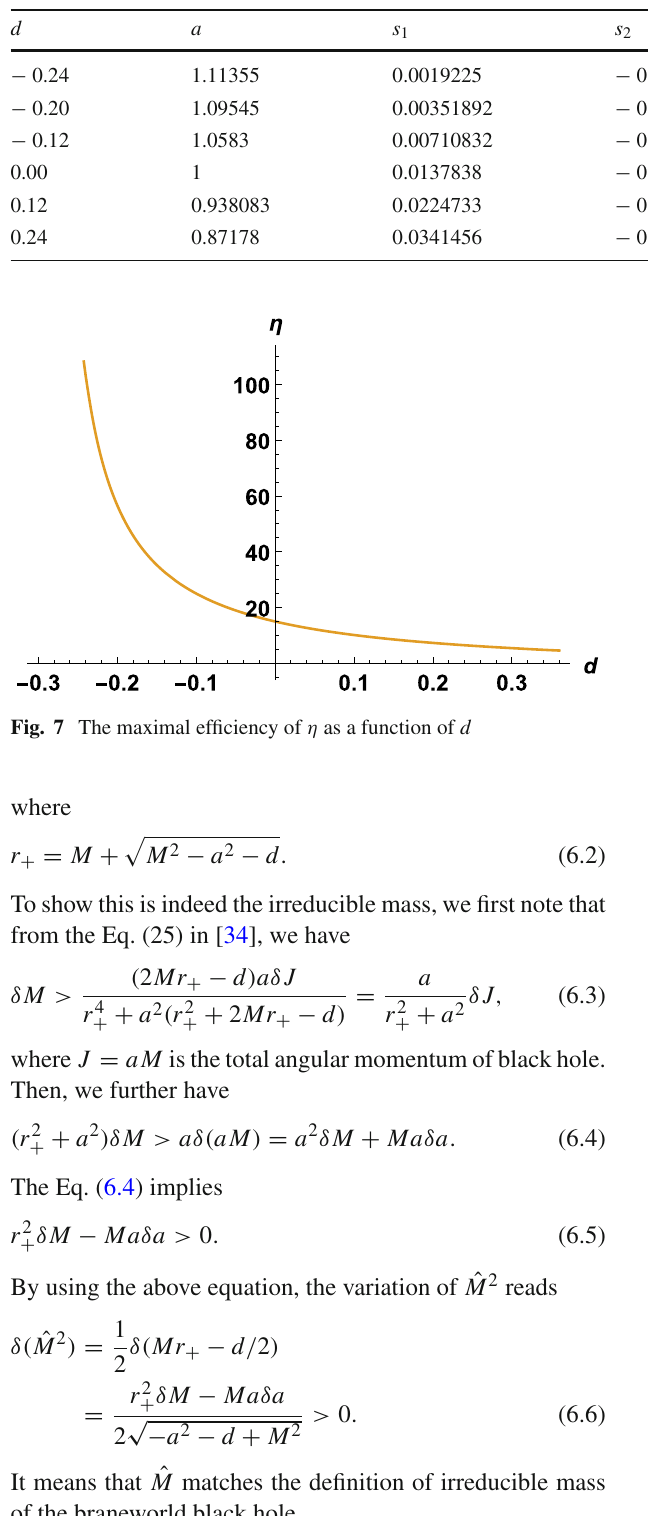
Table 1 The maximal efficiency and its corresponding value of s 1 , s 2 and E 2 for different d